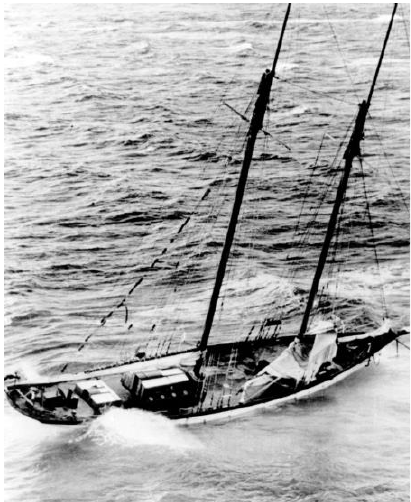
Figure 1. Mandalay aground on Long Reef, New Year’s Day, 1966. (Image courtesy of the Miami Herald).